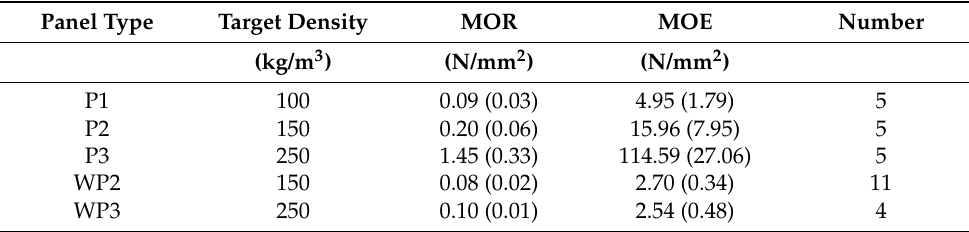
Table 2. Overview of MOR and MOE testing (SD in